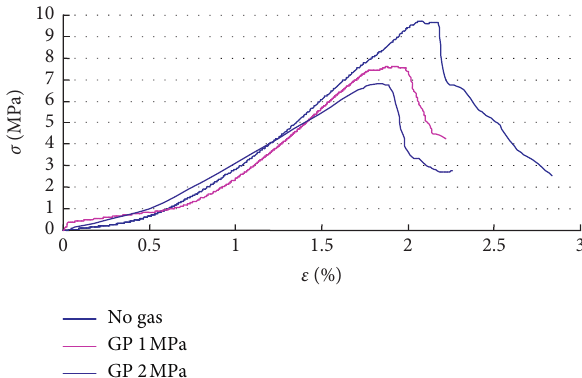
Figure 17: Stress-strain curves of coal samples compressed under different gas conditions.